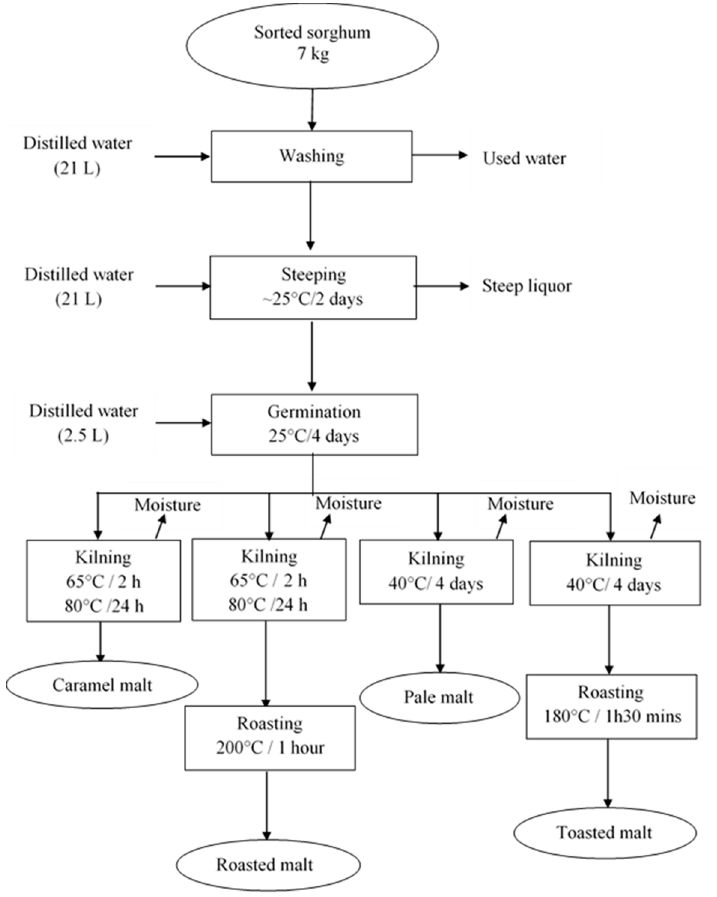
Figure 7. Sorghum malting process.